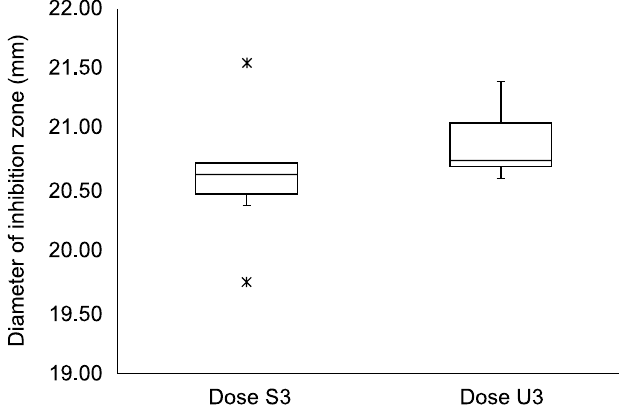
(reference standard) and U 3